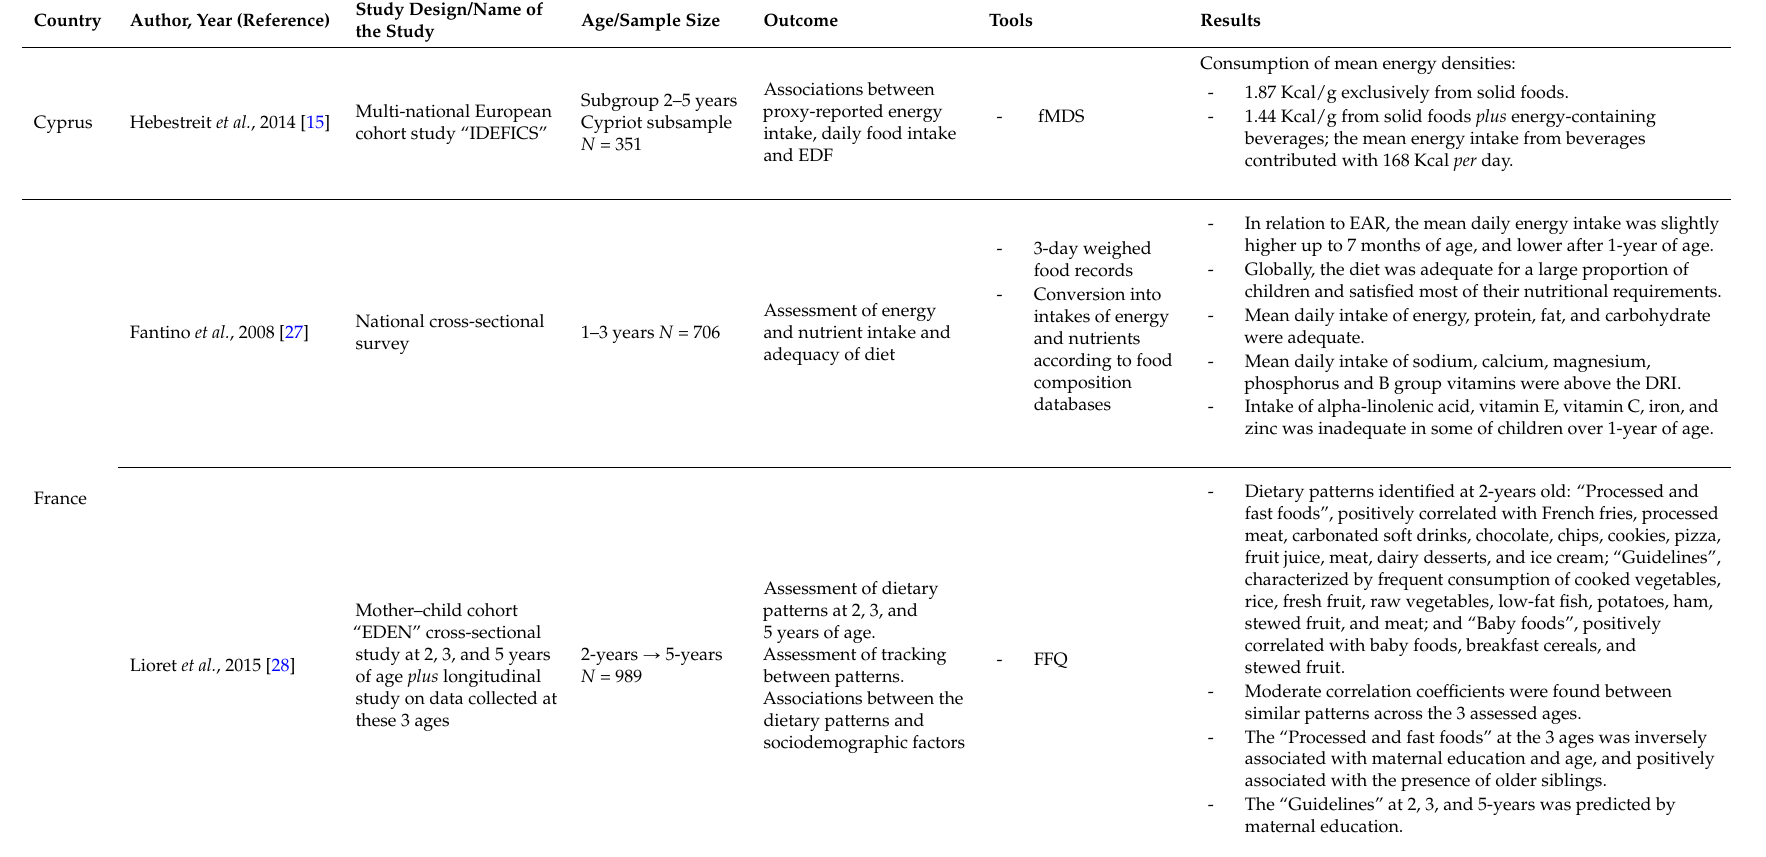
Table 2. National data on dietary habits and weight status of preschool children living in Mediterranean countries of the European